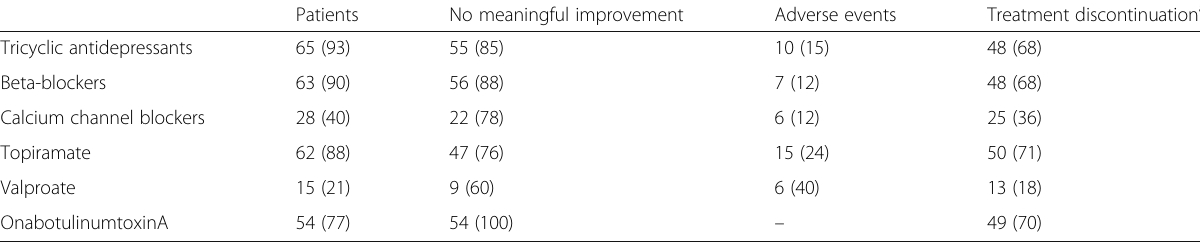
Table 2 Prior anti-migraine preventive therapies of patients ( N = 70) in the study, showing pharmacological classes and corresponding reason for